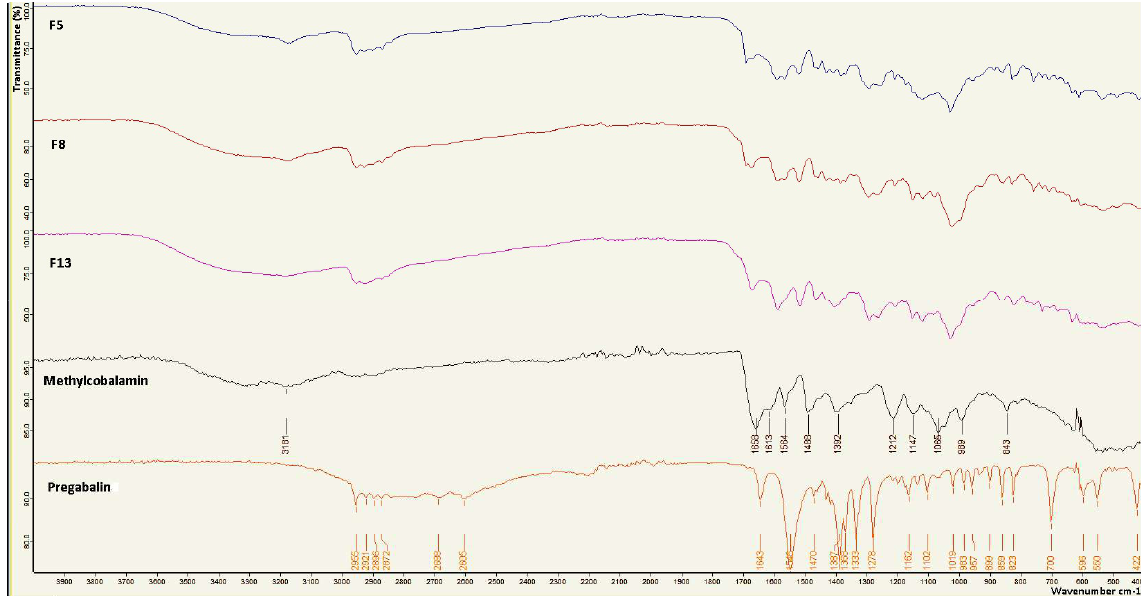
Figure 5. FT-IR spectra of PG, MC, and optimum formulations .